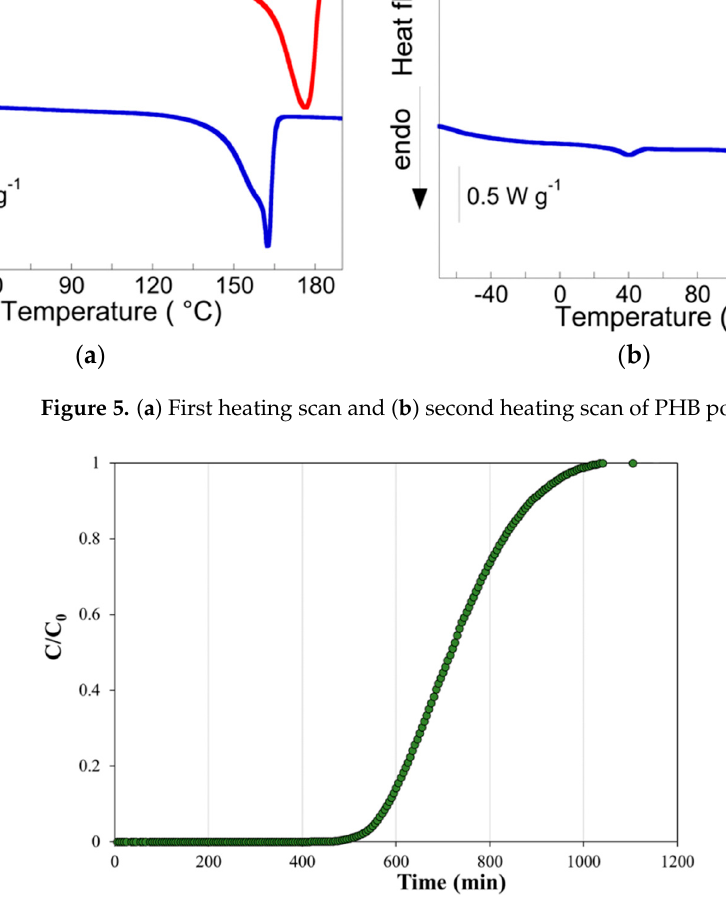
Figure 5. ( a ) First heating scan and ( b ) second heating scan of PHB powder and pellets.